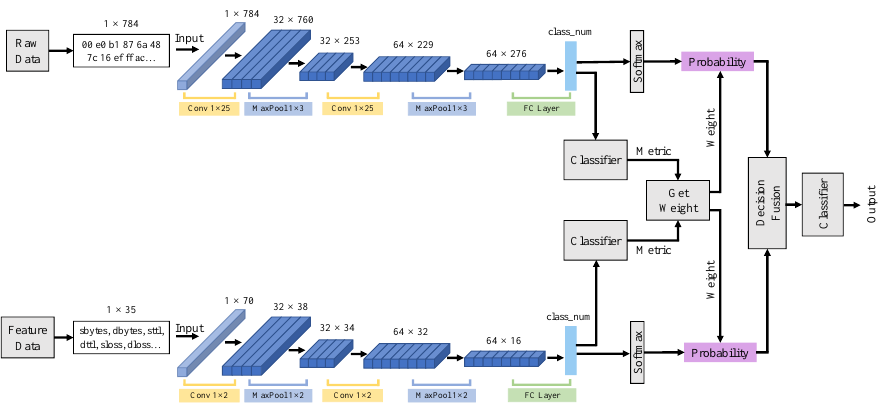
Figure 4. The structure of decision fusion. The fusion process occurs at the end of detection procedure.